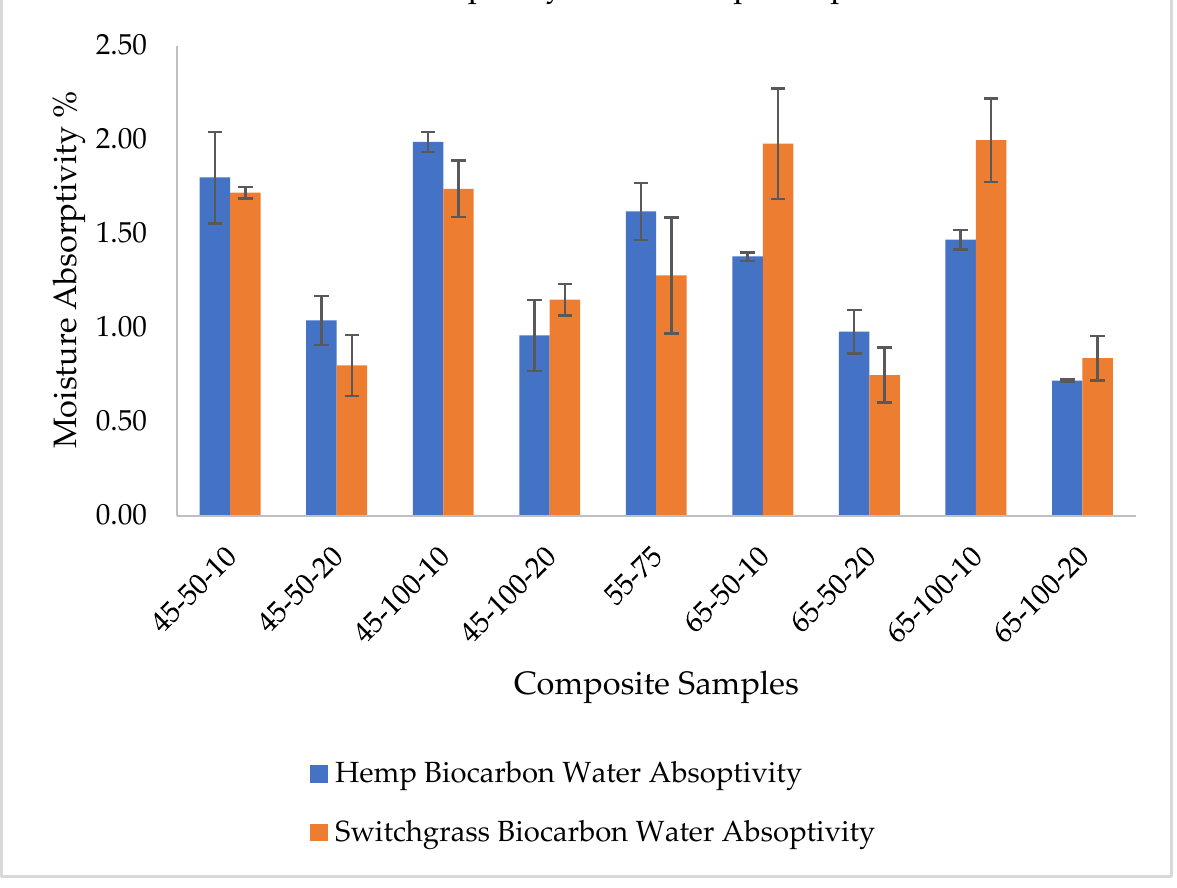
Figure 8. Difference in mean water absorptivity of various composite samples.